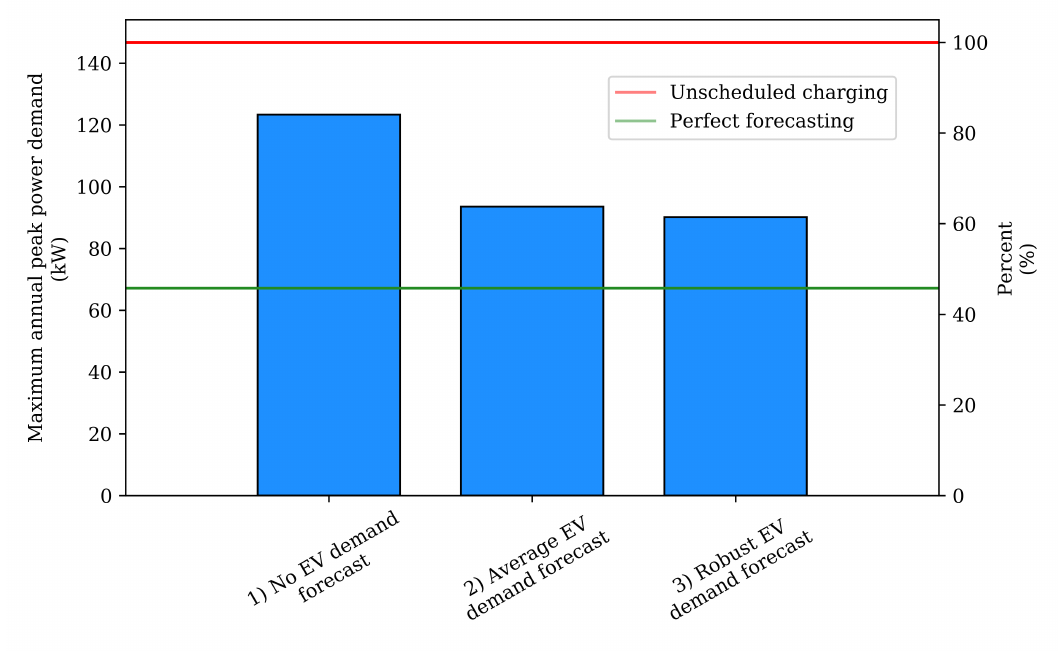
Figure 5. Comparison of annual peak power exchange with the